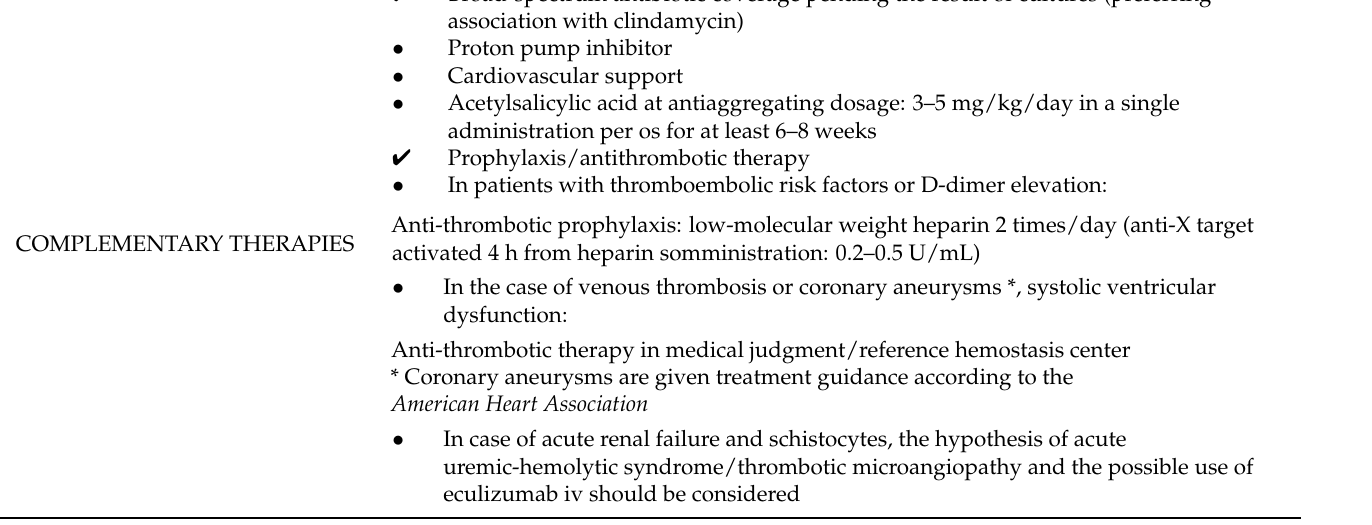
COMPLEMENTARY THERAPIES